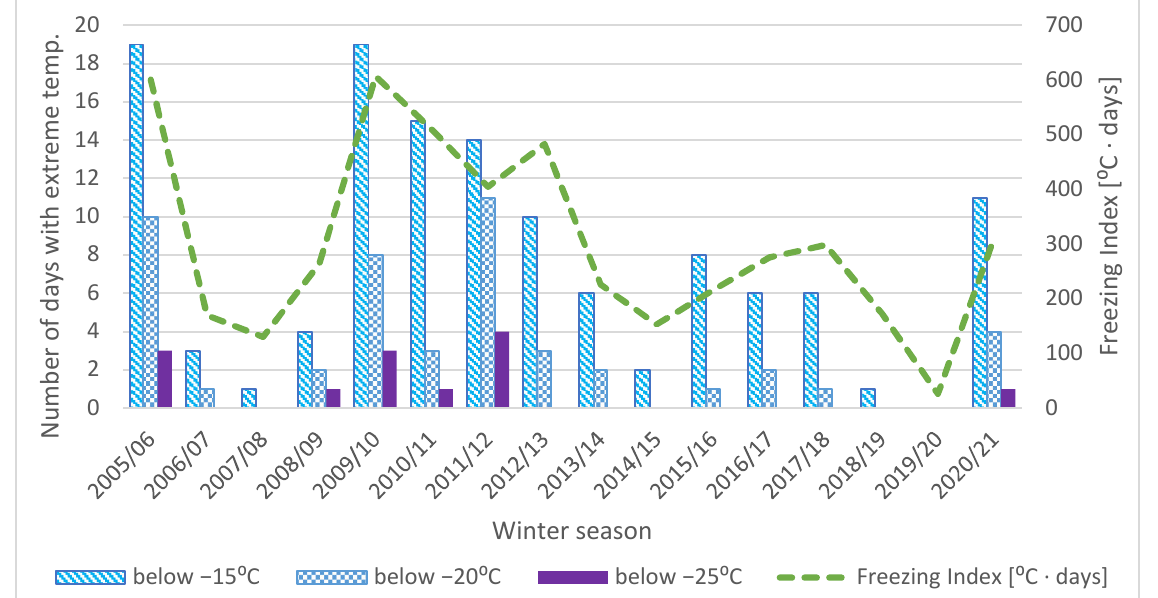
Figure 2. Freezing index and number of days when low air temperatures fell below the level of −15 °C, −20 °C, and −25 °C for the considered sections.